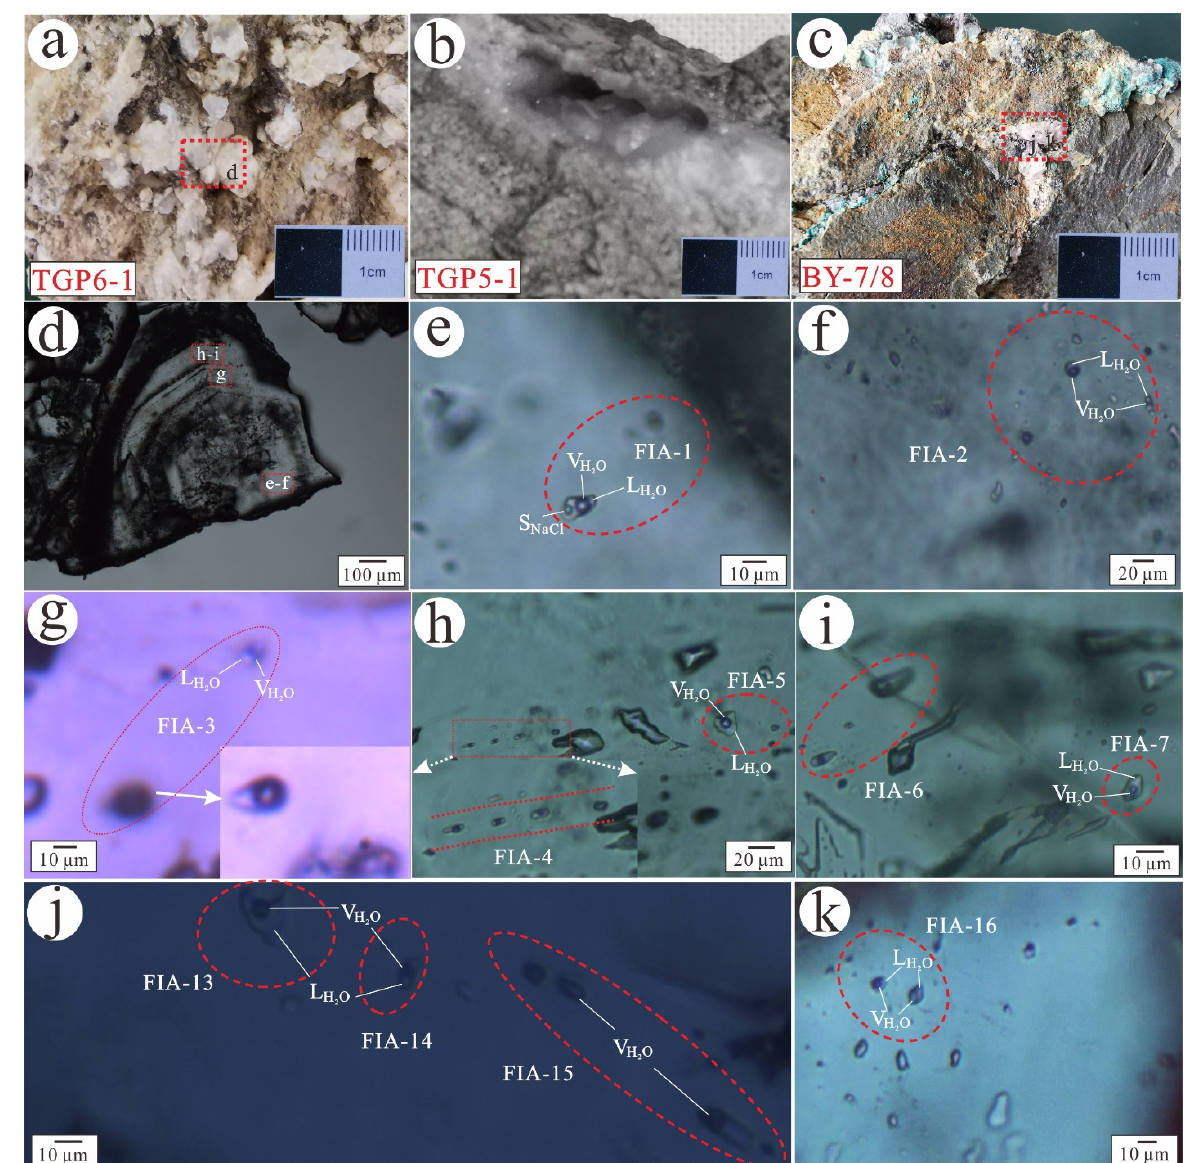
Figure 5. Specimen photographs and photomicrographs of FIAs in quartz from the porphyry Cu mineralization of Tonggou deposit. ( a ) Granular quartz sample from magnetite–quartz stage; ( b ) granular quartz vein; ( c ) chalcopyrite–quartz vein; ( d ) granular quartz sample from magnetite– quartz stage show growth bands; ( e ) Boiling FIA (S- and V-type FIs) in the core of sample TGP6-1; ( f ) L-type FIA and V-type FIA in the cire of sample TGP6-1; ( g ) L-type FIA and V-type FIA in the transition of sample; ( h ) L-type FIA and V-type FIA in the rim of sample TGP6-1; ( i ) L-type FIA in the rim of sample TGP6-1; ( l – k ) L-type FIA and V-type FIA in sample BY-7; L (liquid phase), V (vapor phase), S (daughter mineral).